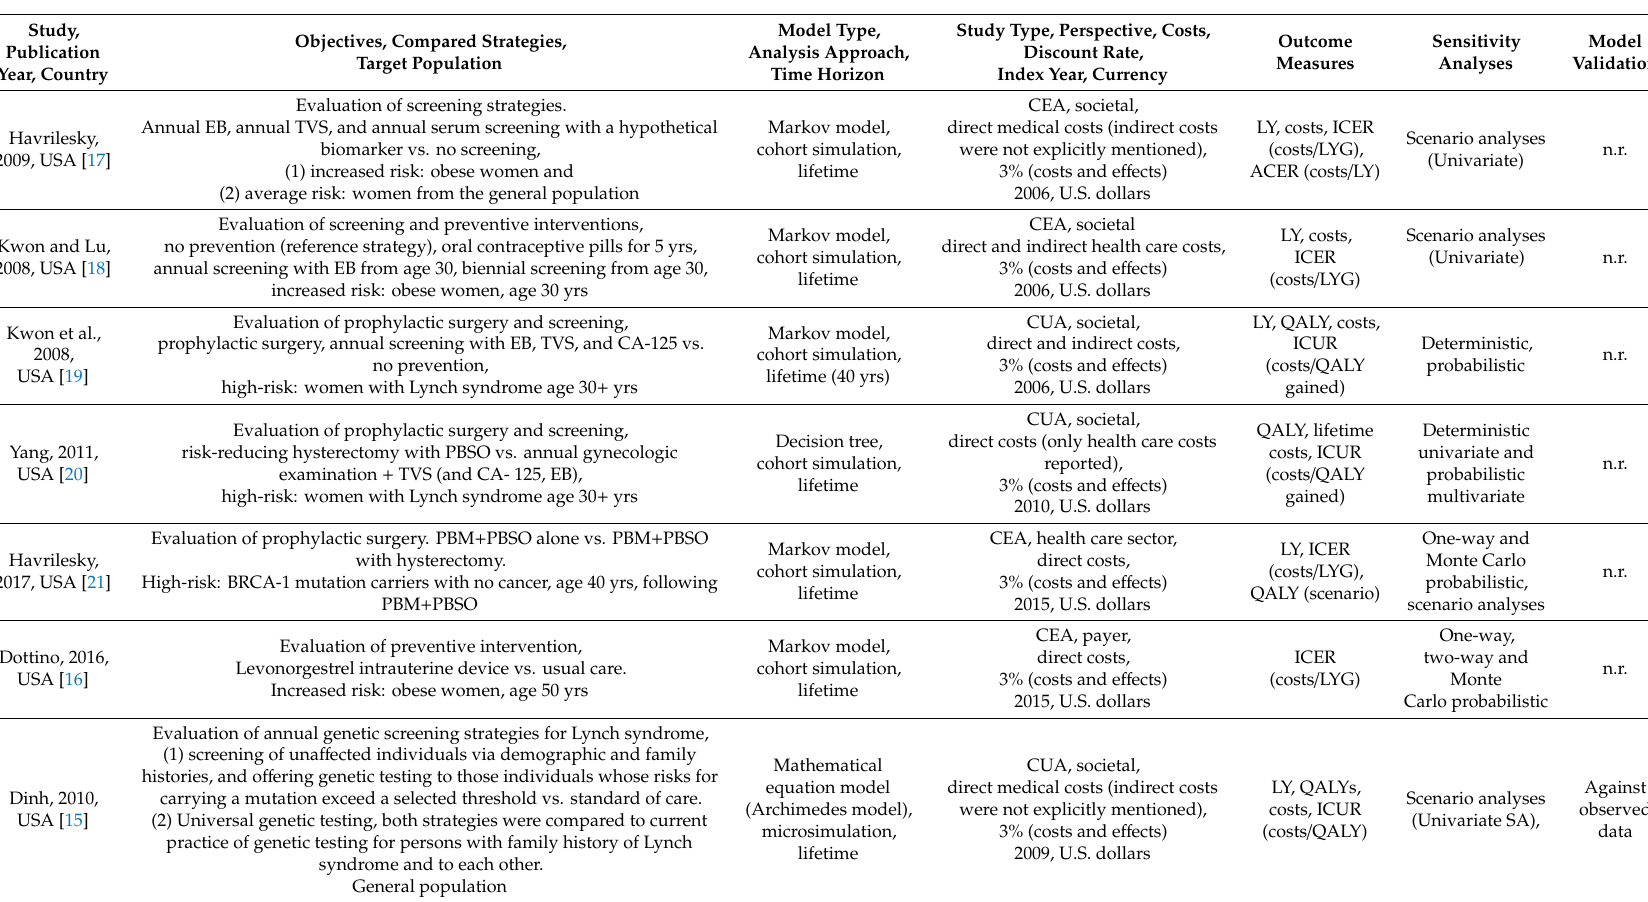
Table 1. Characteristics of Cost-E ff ectiveness Studies Evaluating Endometrial Cancer Screening and / or Prevention Strategies Sorted by Intervention